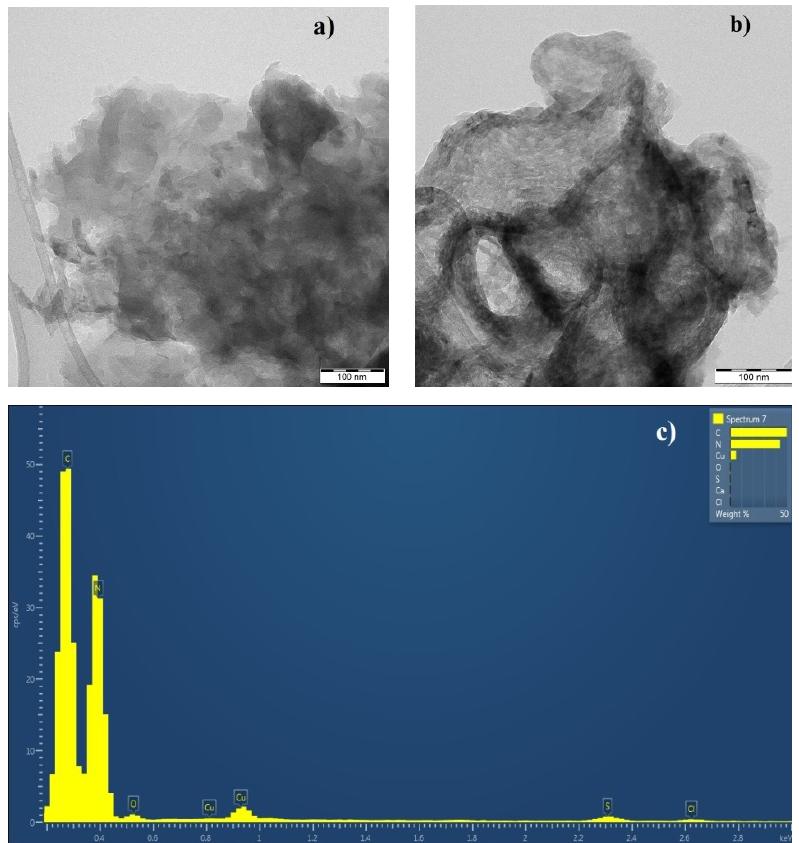
Figure 4. Transmission electron microscopy (TEM) micrographs of Mes-CN ( a ), Mes-ExCN ( b ), and EDX spectrum of Mes-ExCN ( c ).